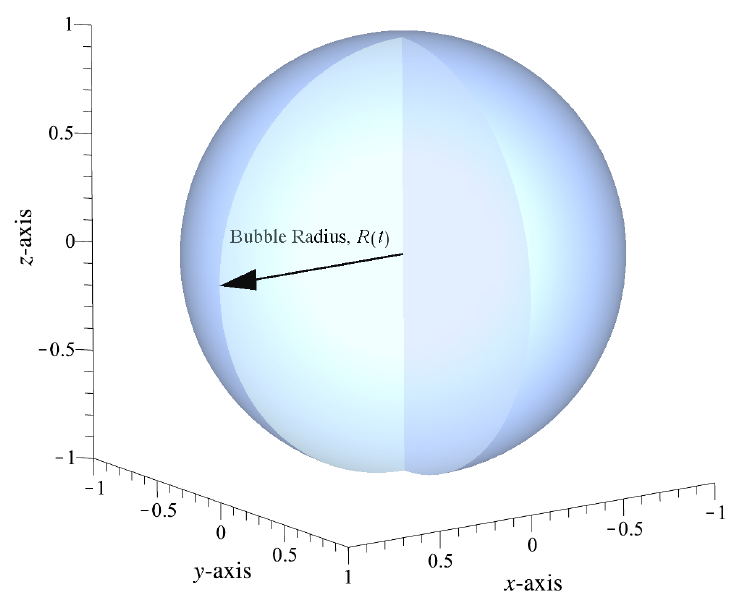
Figure 3. Schematic depicting a sphere with a time-varying radius R ( t ) . This is measured from the center of the sphere outward, and it is the primary variable of interest in a bubble process such as a Raleigh–Plesset